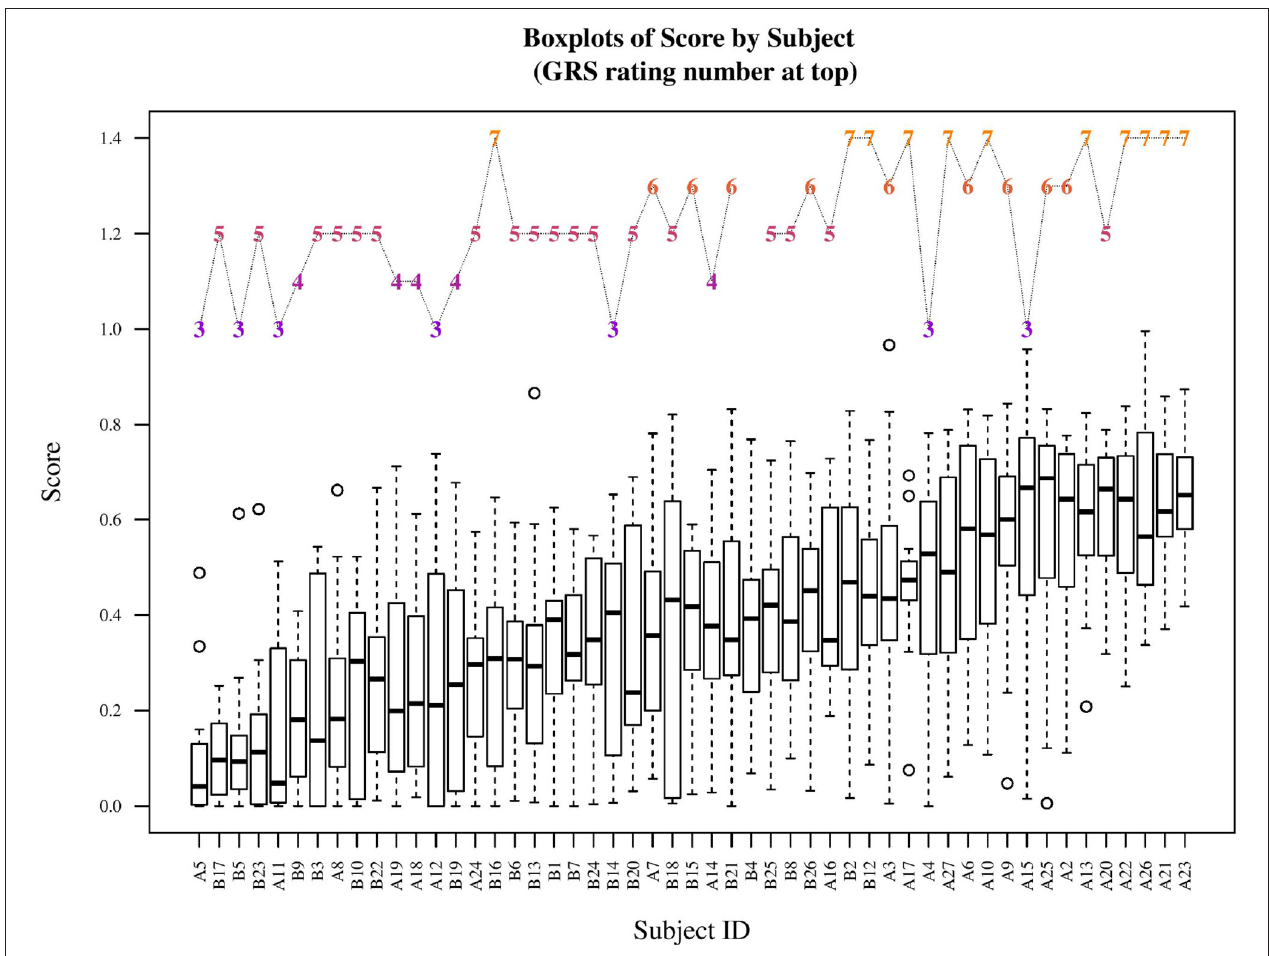
FIGURE 7 | The outcome scores for each subject along with the overall GRS rating. (Note: subjects are sorted by their mean outcome scores.) One participant (B4) did not have a GRS scoring sheet since no preceptor was available at that time.